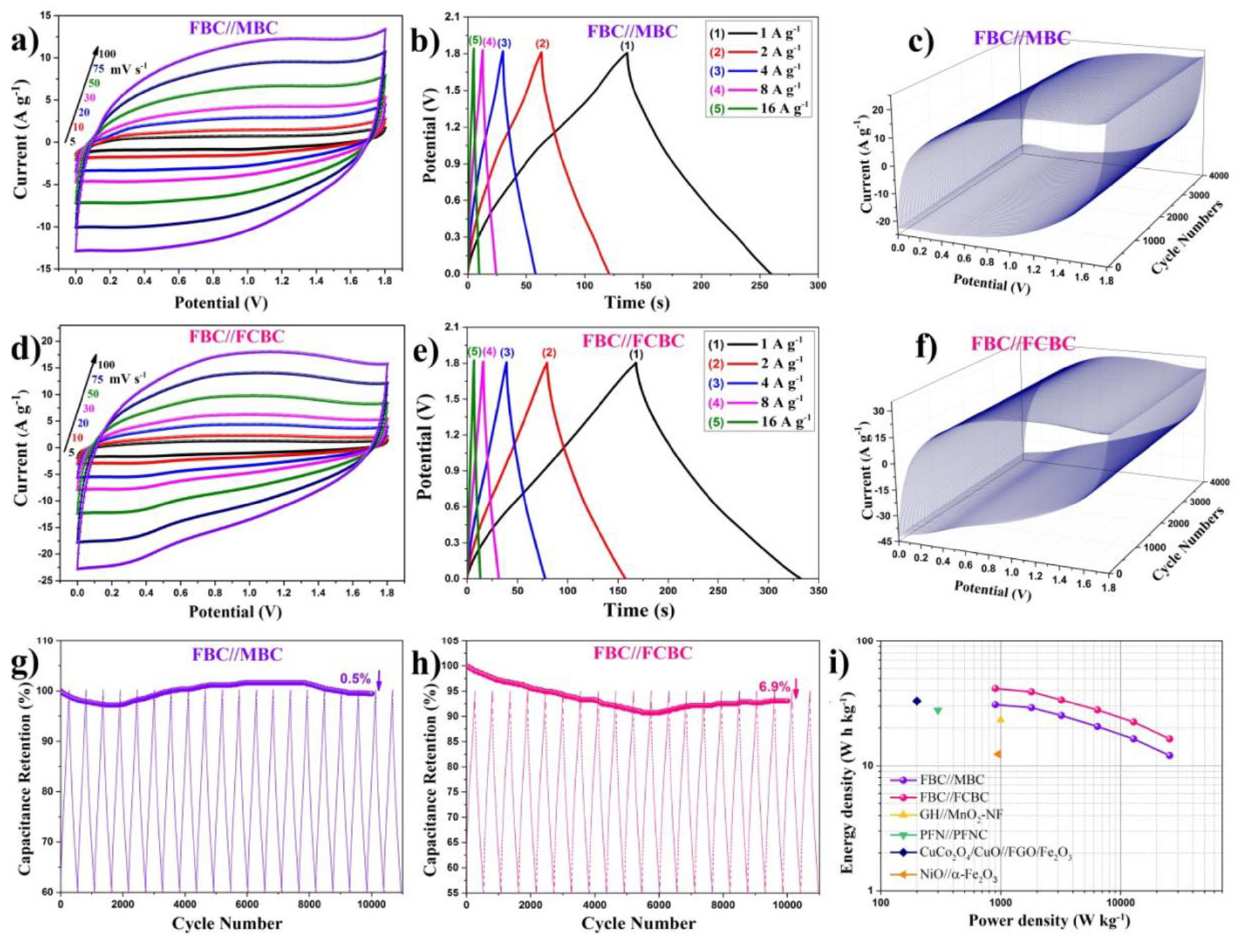
Figure 7. CV curves at different scan rates of FBC//MBC and FBC//FCBC ( a , d ), charge/discharge curves under different current densities of FBC//MBC and FBC//FCBC ( b , e ), 3D − CCV curves of the FBC//MBC and FBC//FCBC electrodes measured at scan rate of 200 mV s − 1 ( c , f ), cycle performance of the FBC//MBC and FBC//FCBC electrodes at a the current density of 8 A g − 1 ( g , h ), Ragone plot of FBC//MBC and FBC//FCBC ( i ) [127]. Reprinted with permission from [127]. Copyright 2018 American Chemical Society.